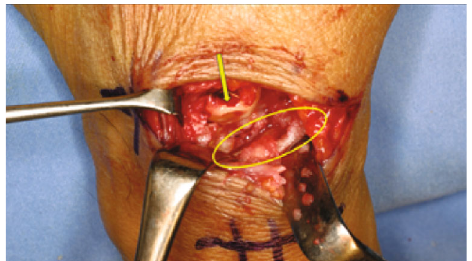
Figure 2: A cartilage defect is observed in the capitate bone (arrow). A proximal-type scaphoid pseudarthrosis with bony growth into the dorsal ridge is observed (oval).